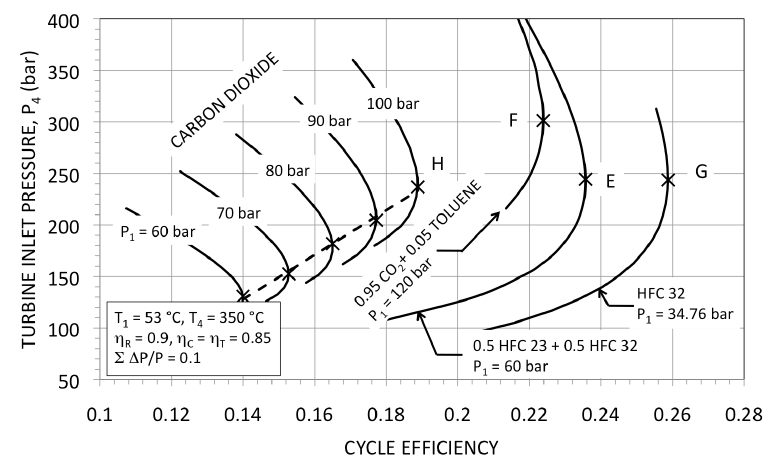
Figure 13. Turbine inlet pressure as a function of the thermodynamic cycle efficiency for pure fluids and for two different mixtures.